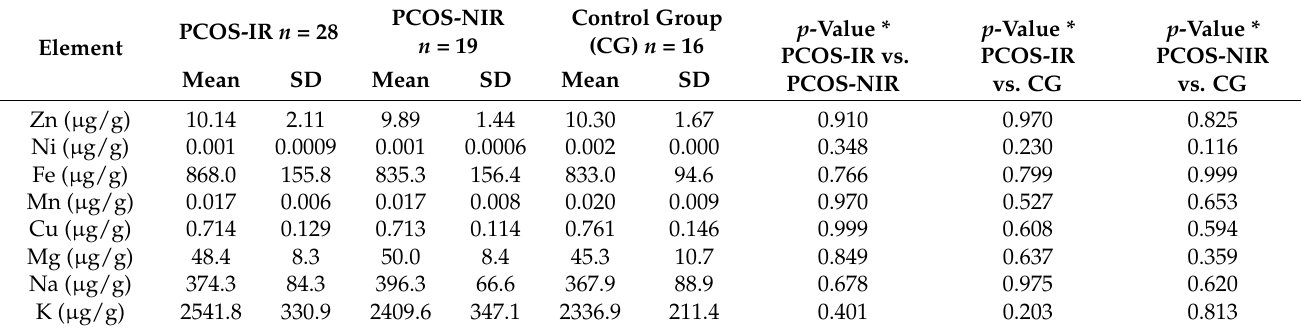
Table 4. Average content of elements in erythrocytes ( µ g/g).